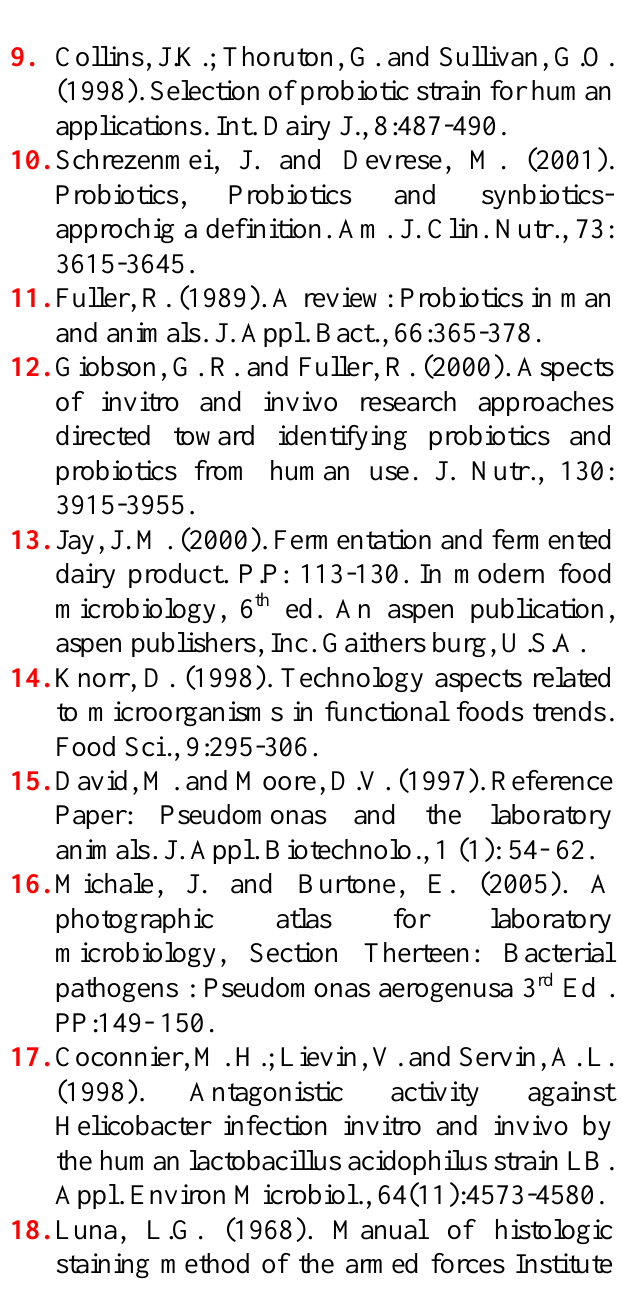
Figure, 9: Section in ear of animal treated with dandelions extract at 48 hr of infection show little inflammation cell infiltration around hair floccule. H& E stain 40X.